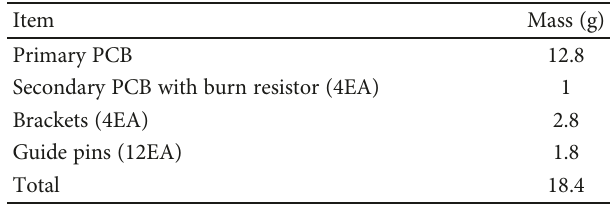
Table 2: Mass budget of the demonstration model of the